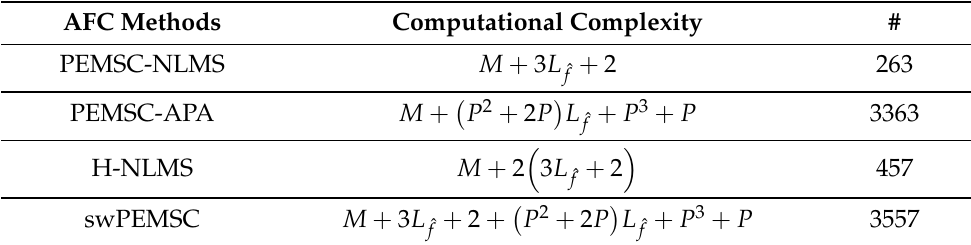
Table 1. Computational complexity per output sample.